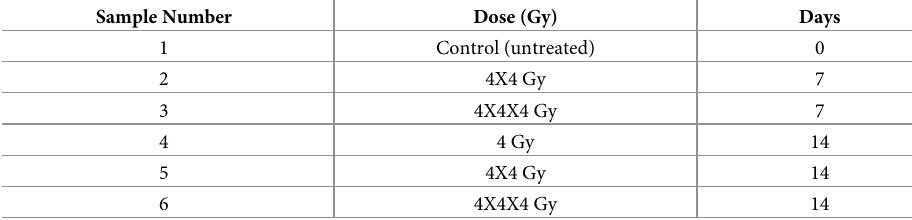
Table 1. Irradiation treatment schedule for all 6 HRPTEC